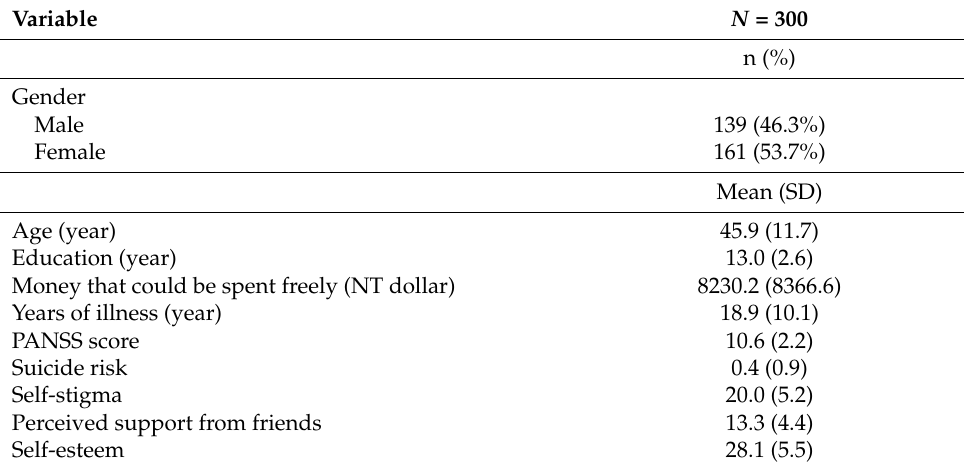
Table 1. Characteristics of participants ( N =